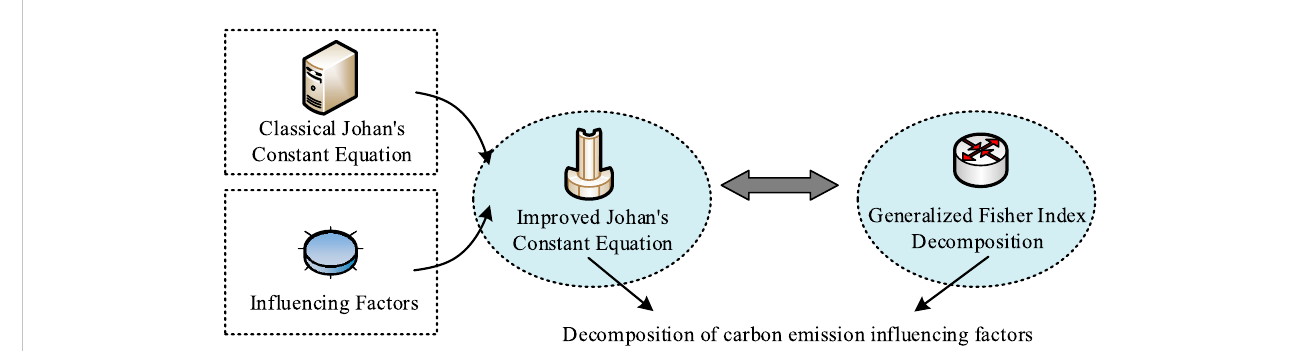
FIGURE 4 Decomposition model of carbon emission in fl uencing